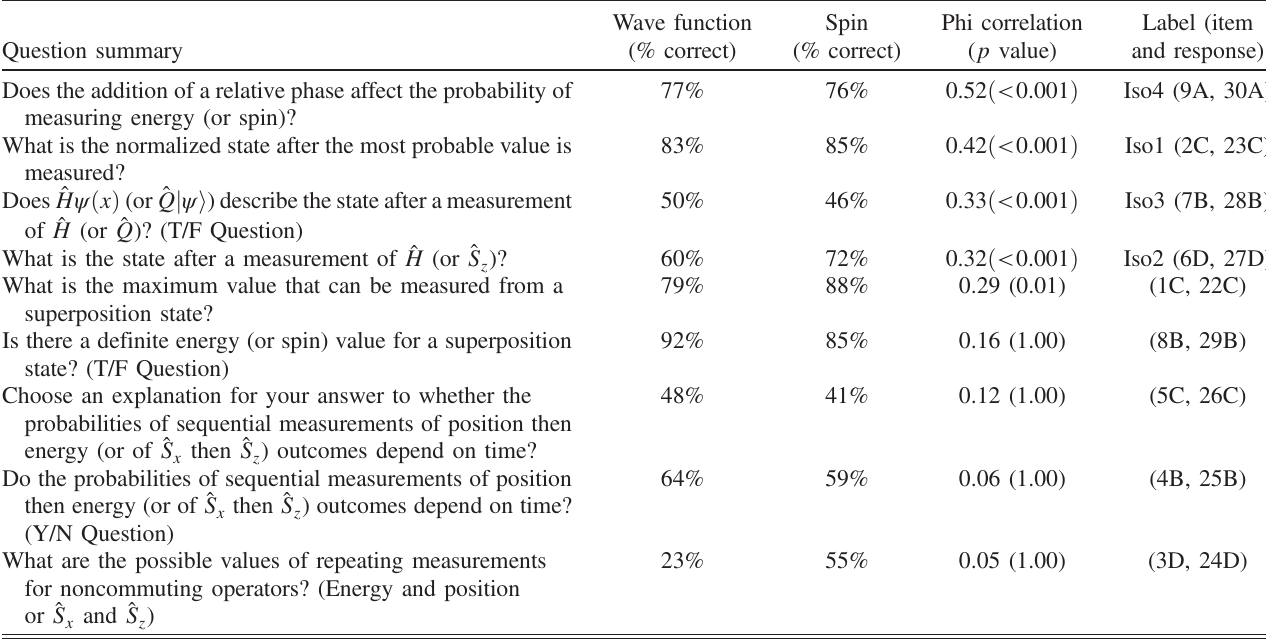
TABLE I. Partial correlation values between correct responses on paired questions controlling for the total score. Labels refers to the module identification in Fig. 3. If no label is provided the pairing does not appear as a module in the MMA-P analysis Fig. 3. Question numbers refer to QMCA version 6.2.2 with the letter indicating the answer